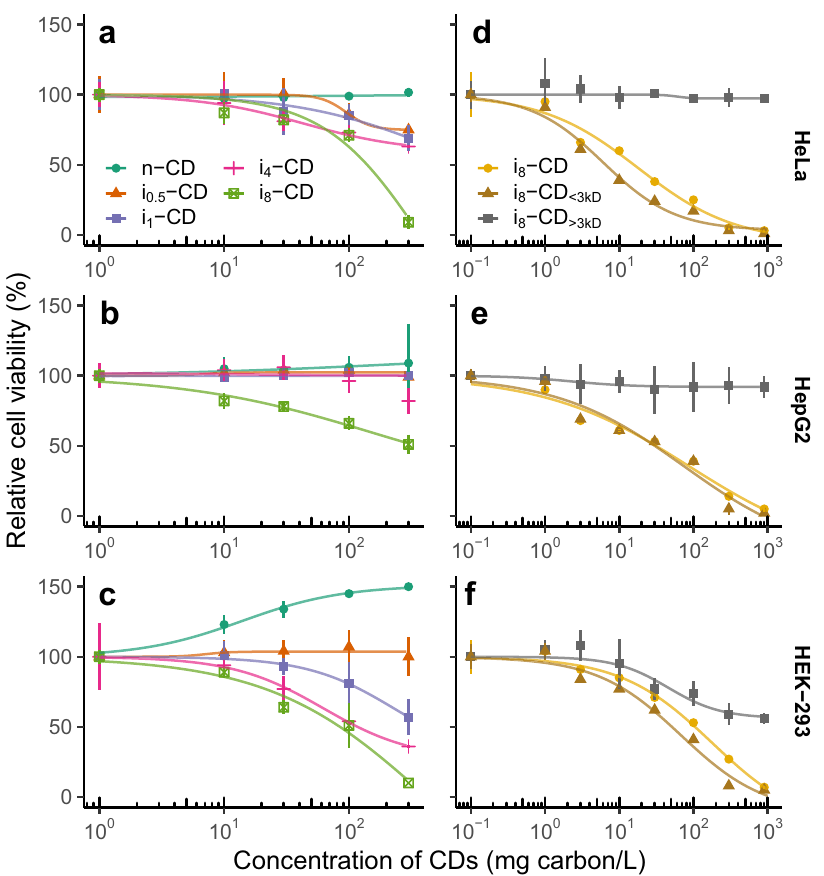
Fig. 2 Cell viability testing of laboratory-synthesized carbon dots (CDs). a – c Dose – response data show the cytotoxicity of CDs to HeLa ( a ), HepG2 ( b ), and HEK-293 ( c ) cells increased with irradiation time. The three cell lines were exposed to different concentrations (0, 10, 30, 100, and 300 mg carbon/L) of CDs that have been irradiated with white fl uorescent light (60 μ mol photons/m 2 /s) for 0 (n-CD), 0.5 (i 0.5 -CD), 1 (i 1 -CD), 4 (i 4 -CD), and 8 (i 8 -CD) days. d – f Dose – response data show the photolyzed products in the <3 kD fraction contributed substantially to the photo-induced cytotoxicity of CDs to HeLa ( d ), HepG2 ( e ), and HEK-293 ( f ) cells. The cytotoxicity of both the <3 kD fraction containing photolyzed molecules (i 8 -CD <3 kD ) and the >3 kD fraction containing degraded CDs (i 8 -CD >3kD ) was compared with that of the total un fi ltered suspension of i 8 -CD at concentrations of 0, 1, 3, 10, 30, 100, 300, and 900 mg carbon/L. Data are presented as the mean ± s.d. ( n = 6 independent experiments). Source data are provided as a Source Data fi i 8 -CD <3kD to be more toxic than n-CD and i 8 -CD >3kD , which is consistent with the cell viability results in Fig. 2. As shown in Fig. 3a, the EC DEG values were 0.00017 – 3.9 mg carbon/L for i 8 - CD, 0.00019 – 28.4 mg carbon/L for i 8 -CD <3kD , 0.092 – 1066.7 mg carbon/L for n-CD, and 0.087 – 1150 mg carbon/L for i 8 -CD >3kD .